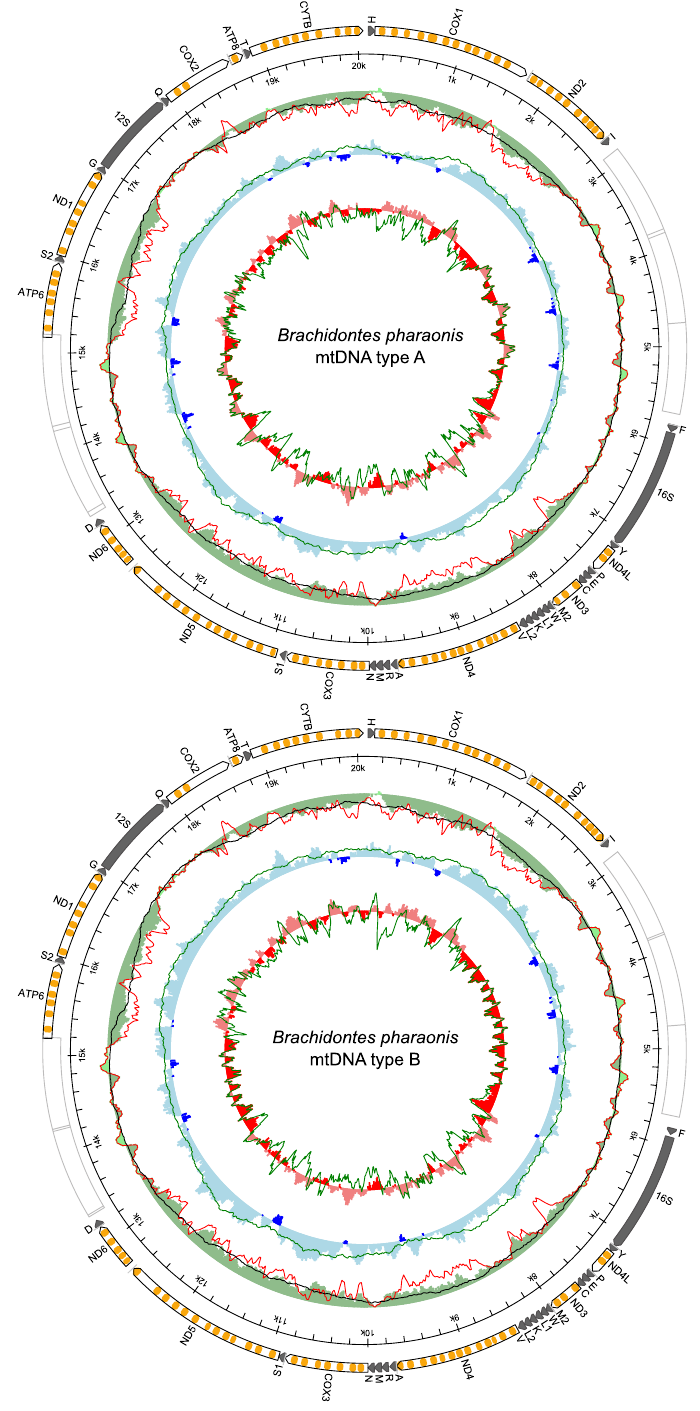
Figure 1. Genetic map of Brachidontes pharaonis mitochondrial genomes. The white arrows with orange bands represent protein-coding genes with predicted transmembrane domains. The dark arrows represent the rRNA and tRNA genes; the white boxes indicate the location of repetitive sequences. The figure and compositional indices were generated with MITOCONSTRICTOR as in 33,34